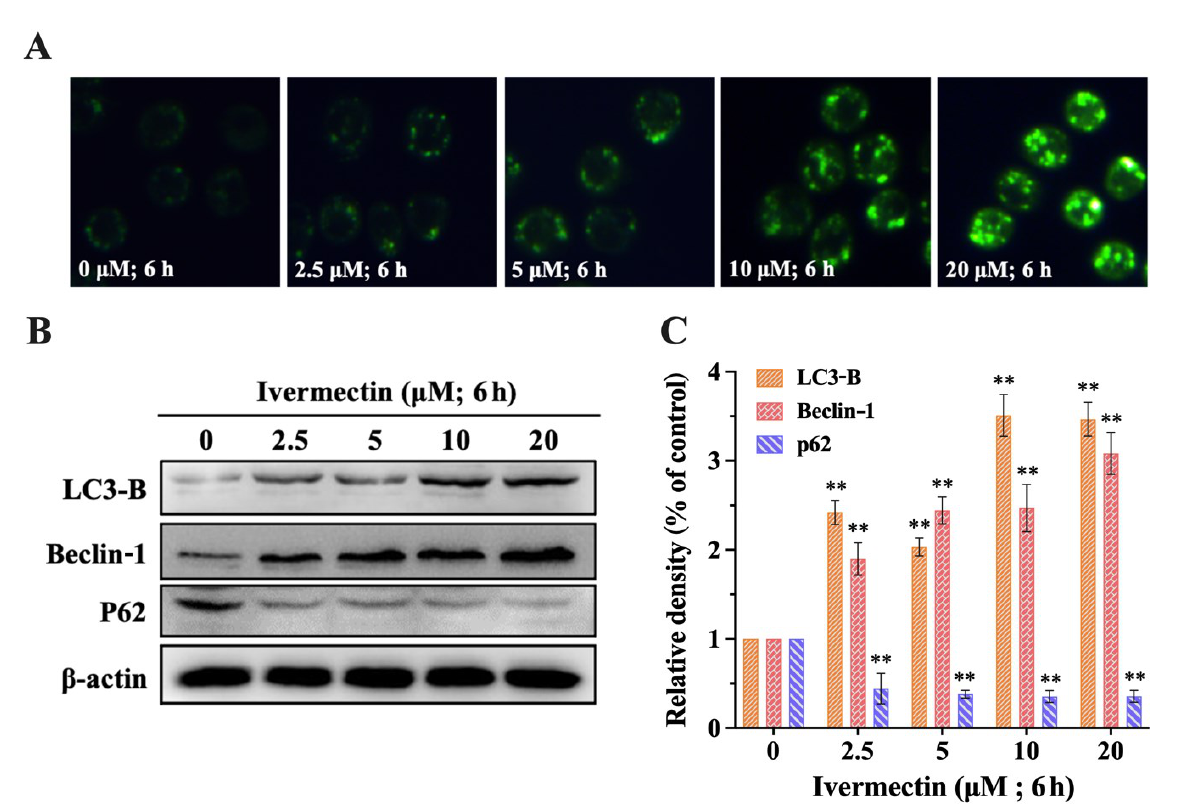
Figure 3. IVM induces autophagy in RAW264.7 cells. ( A ) Representative fluorescence photomicro- graph (200 × ) of RAW264.7 cells stained with MDC after treatment with different concentrations for 6 h. ( B ) LC3-B, Beclin-1, and p62 expression in RAW264.7 cells treated with IVM for 6 h. ( C ) Den- sitometric analysis of the expression levels of LC3-B, Beclin-1, and p62. Data were expressed as means ± SD (standard deviation) of three separate sets of independent experiments. ** p < 0.01, and indicate the significant differences from the control.